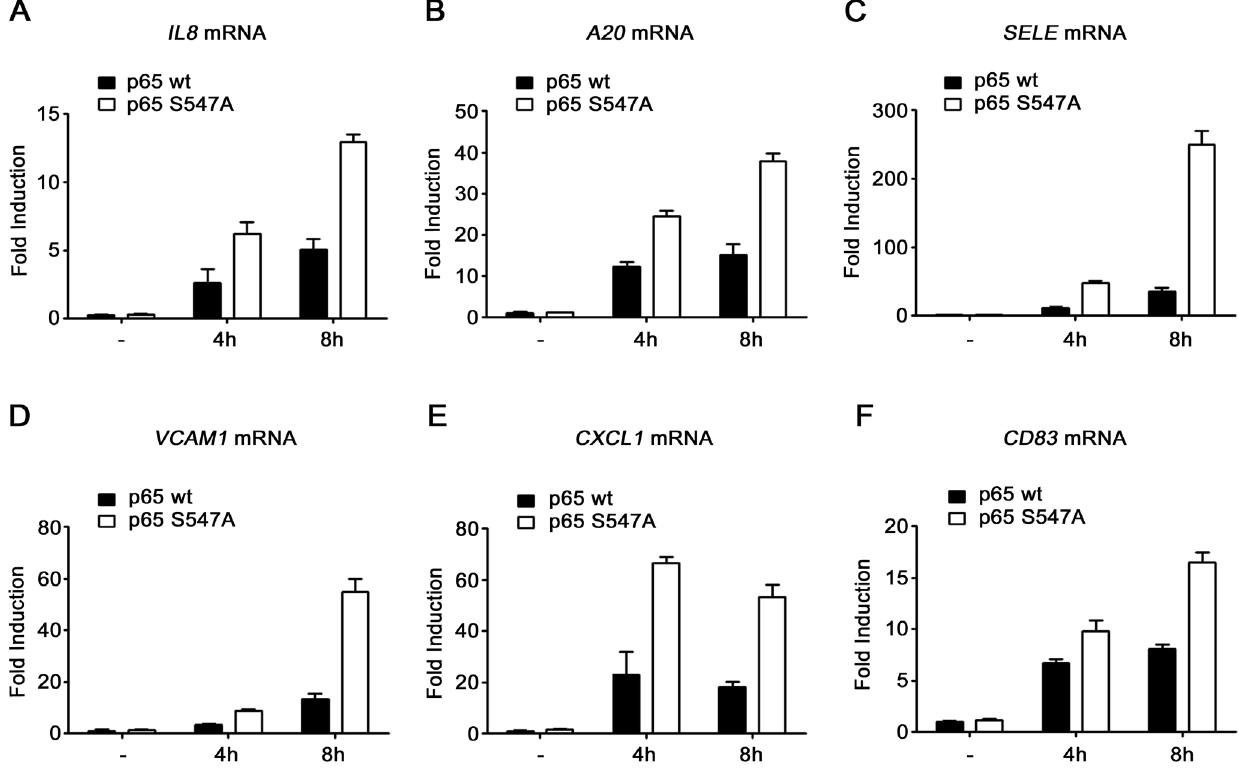
Figure 4. Higher expression of specific genes in cells expressing S547A mutated p65. qRT PCR analysis of IL8 ( A ), A20 ( B ), Sele ( C ), VCAM1 ( D ), CXCL1 ( E ) and CD83 ( F ) mRNA level after 4 and 8 hours of etoposide treatment in HEK-293 cells expressing either p65 wt or p65 S547A .